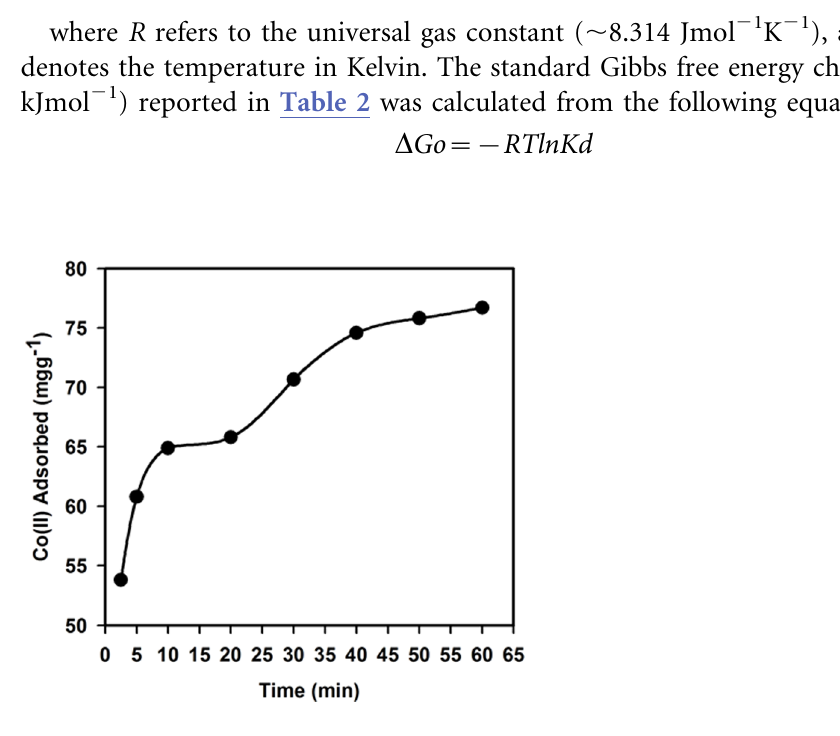
Figure 10. Studies of Adsorption characteristic. Effect of contact time on the adsorption of 125.0 mgL 2 1 Co(II) on 25.0 mg Ag 2 O 3 -ZnO NCs at pH 5.0 and 25.0 ˚